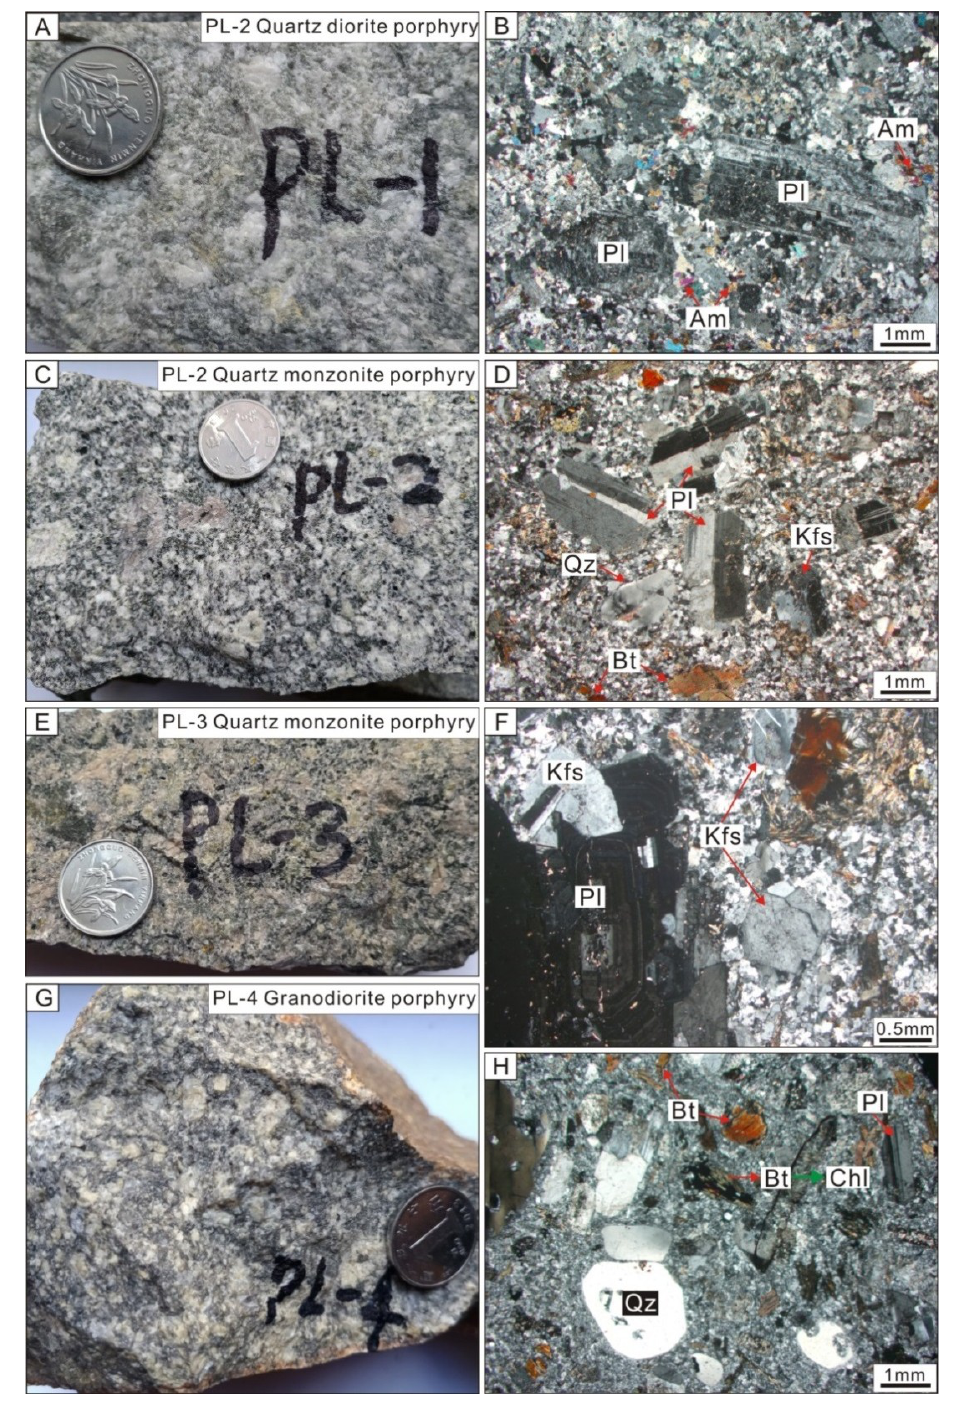
Figure 3. Hand specimen photographs and thin section photomicrographs of the porphyry intrusions in the Pulang ore district. ( A , B ) Quartz diorite porphyry (B under cross-polarized light). ( C – F ) Quartz monzonite porphyry (D and F under cross-polarized light). ( G , H ) Granodiorite porphyry (H under cross-polarized light). Abbreviations: Qz: quartz; Pl: Plagioclase; Kfs: K-feldspar; Bt: Biotite; Am: Amphibole; Chl: chlorite.